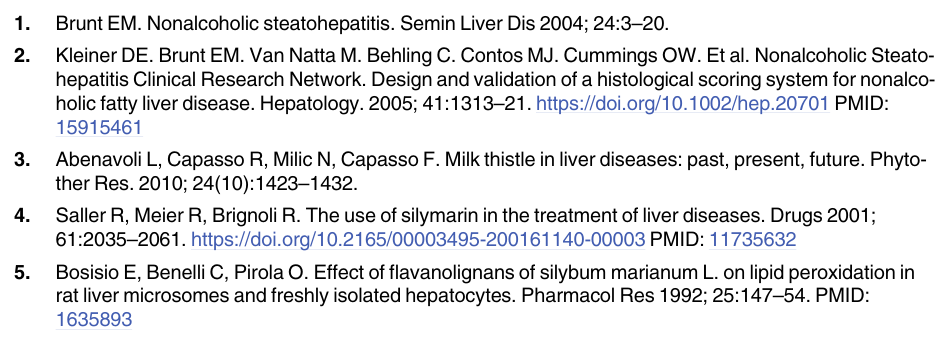
S2 Table. Hepatic histologic scores in patients who met histological inclusion